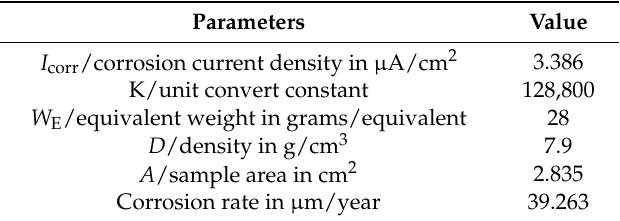
Table 2. Parameters used for corrosion rate calculation in bare steel plate